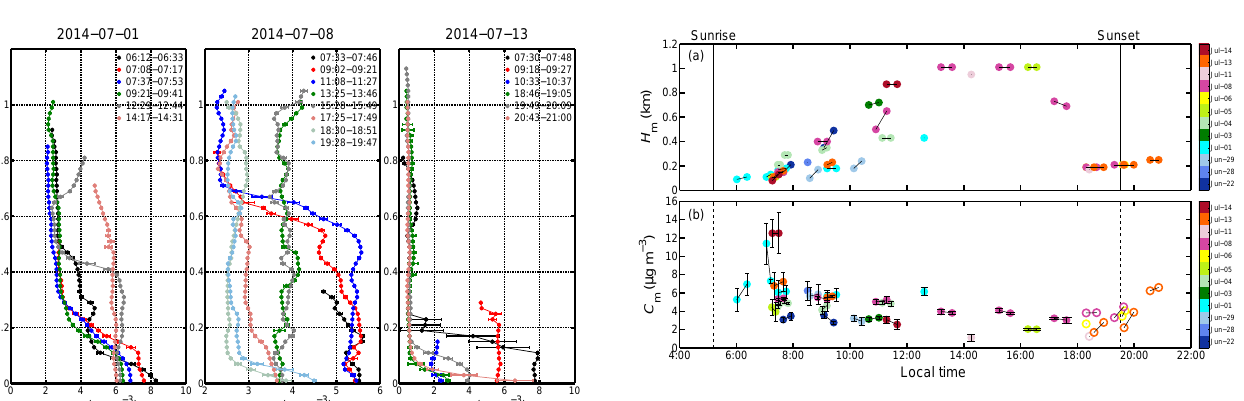
Figure 7. (a) H m identified from BC vertical profiles in the selected dataset. Measurements made on different days are marked by dots in different colors. H m from the ascent and descent of one launch are connected by black lines. (b) Average m BC within the ML ( C m ) during the daytime (before 18:00LT) are marked by solid dots. Av- erage m BC within 20m near the surface in the evening are marked by open